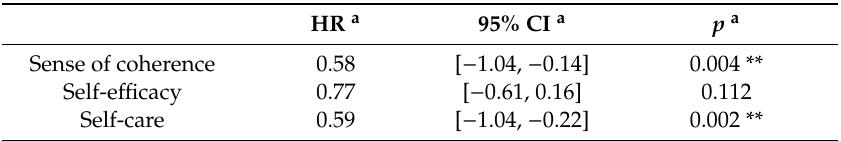
Table 4. Longitudinal association between sense of coherence, self-e ffi cacy, self-care and burnout risk during the course of the study in a combined cox regression model. HR